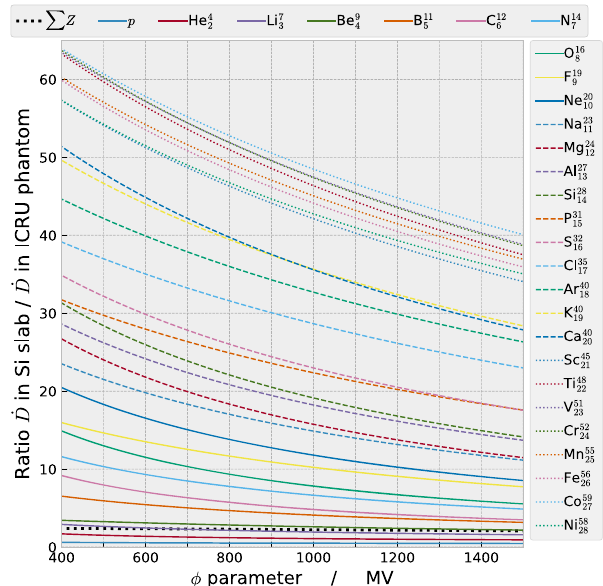
Fig. 9. Modifying the CRaTER- l microdosimeter by adding a 5 mm thick aluminum casing emulates the ICRU sphere. The top panel shows the absorbed dose rate dependence on the modulation parameter / in the range between 400 MV and 1500 MV. Two additional con fi gurations corresponding to 3.3 mm and 8.45 mm of aluminium shielding are shown to present the general trend. The bottom panel compares the absorbed dose rate that an ICRU sphere would suffer to the measurement and to the absorbed dose rate in the modi fi ed microdosimeter. Measuring absorbed dose rate in silicon using such a modi fi ed microdosimeter is suf fi cient to know the absorbed dose rate that a full ICRU water phantom would suffer in open